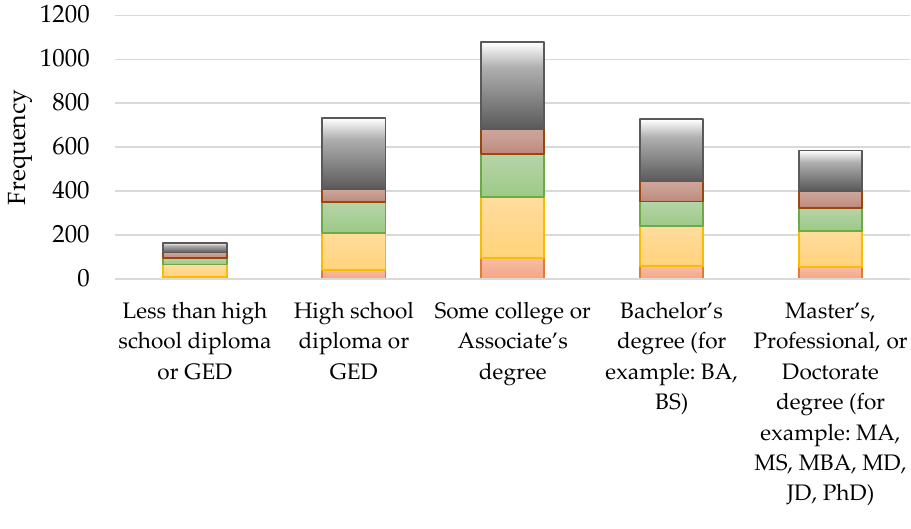
Figure 4. Year the home was built per Building America Climate Zone (total n = 3288). Household characteristics. In terms of household education, about 32.8% of respon- dents indicated they had a college or an associate’s degree, followed by an almost equal distribution of respondents with a high-school diploma or GED (n = 22.3%) and bachelor’s degree (n = 22.1%); 17.8% of respondents had some sort of graduate degree, and only 5% had less than a high-school diploma or GED. This distribution seems to be similar for every region, as can be seen in Figure 5. We note that this question only asked for the respondent’s highest educational degree and does not include information about the educational degrees of all household members.